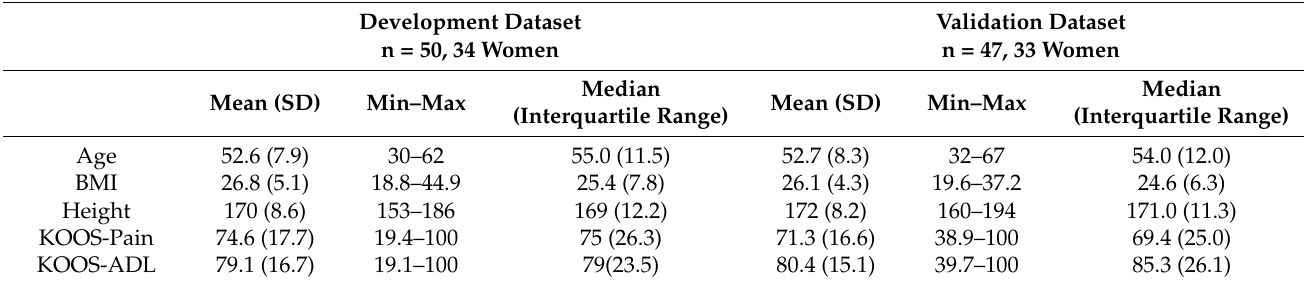
Table 1. Description of the population in the development and validation